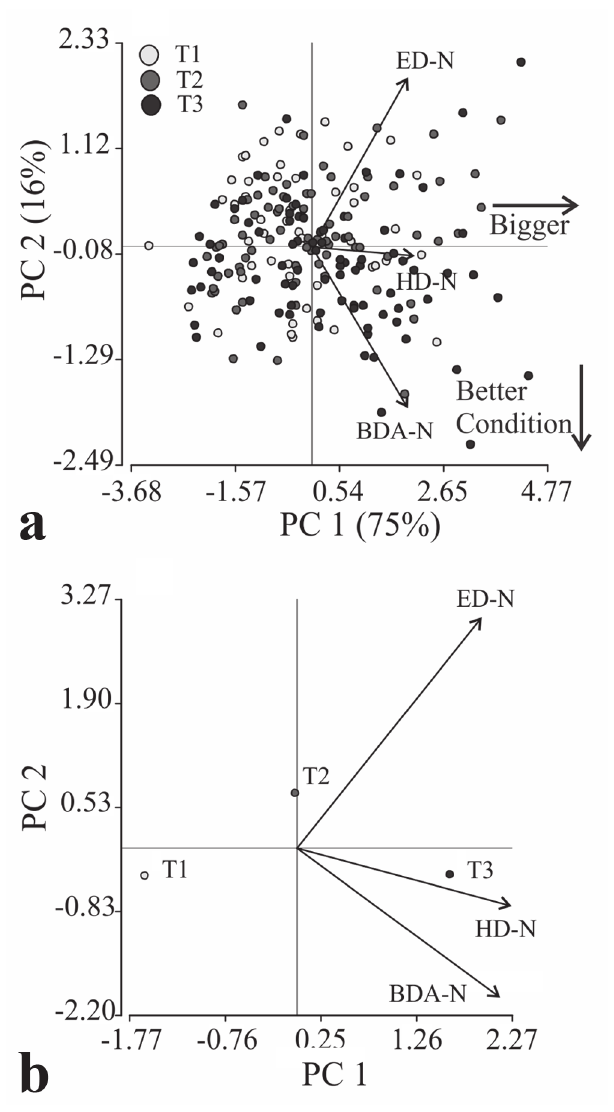
Fig. 2. Scatterplot of PC2 on PC1 for Pagrus pagrus larvae from the feeding treatments. a: PCA based upon normalized morphometrical variables; b: PCA based upon normalized morphometrical variables and observations grouped by feeding treatments. Correlations between the variables also showed. BDA: body depth at the anus, ED: eye diameter, HD: head depth. T1: without food, T2: delayed feeding and T3: fed. –N indicates normalized morphometrical